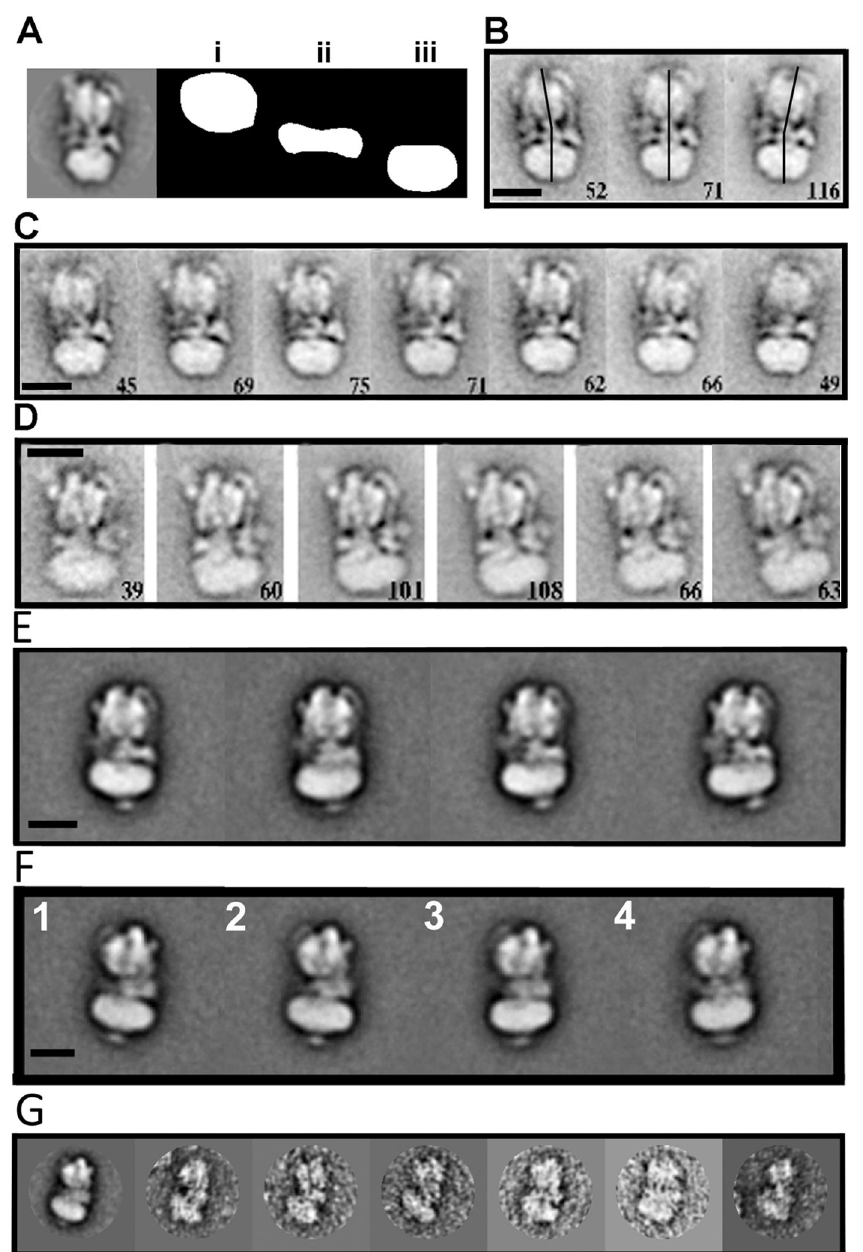
Figure 2. Negative stain electron microscopy of the Saccharomyces and Manduca sexta V-ATPases. (A) A representative class of yeast V-ATPase alongside the 3 masks used to extract the V (i), central (ii) and V domains (iii). (B, C) Yeast V-ATPase 1 o classes of particles belonging to the same orientation, as determined from multi-reference alignment, re-aligned to V and classified o using a mask over V . (D) Yeast V-ATPase particles of particular views aligned against V and classified by V . Numbers in the 1 1 o bottom right corner of B-D, are particle numbers in each class. (E, F) M . sexta V-ATPase classes of particles belonging to the same orientation and aligned against V and classified around V . (G) M . sexta V-ATPase class (far left) and representative views of some 1 o of the particles making up the class. In all cases scale bars represent 120Å.